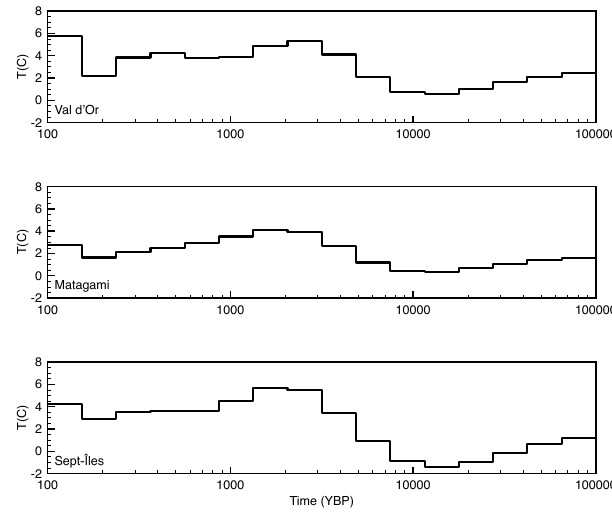
Figure 7. Ground surface temperature history for the boreholes in Québec, Matagami, Val d’Or and Sept-Îles. The temperatures have been shifted with respect to the reference surface temperature of the site, T o , as shown in Table 2.